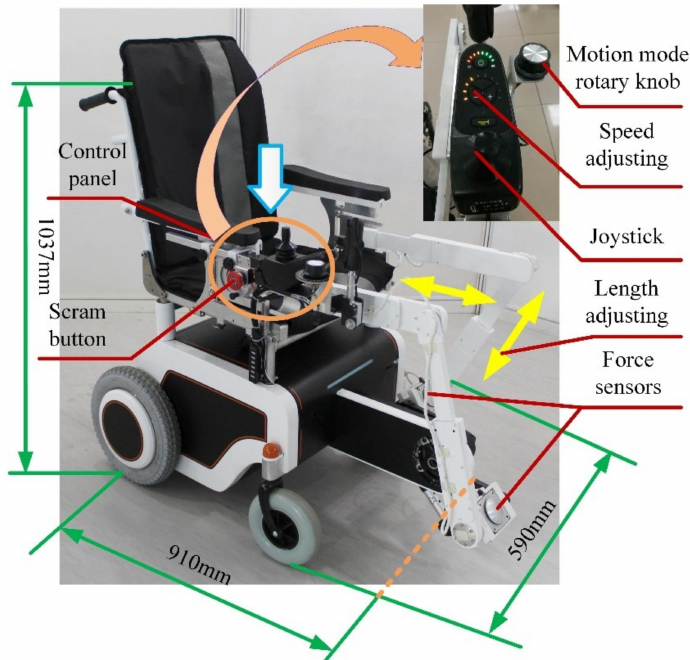
Figure 5. Newly developed wheelchair prototype with linked exoskeletons from the Intelligent